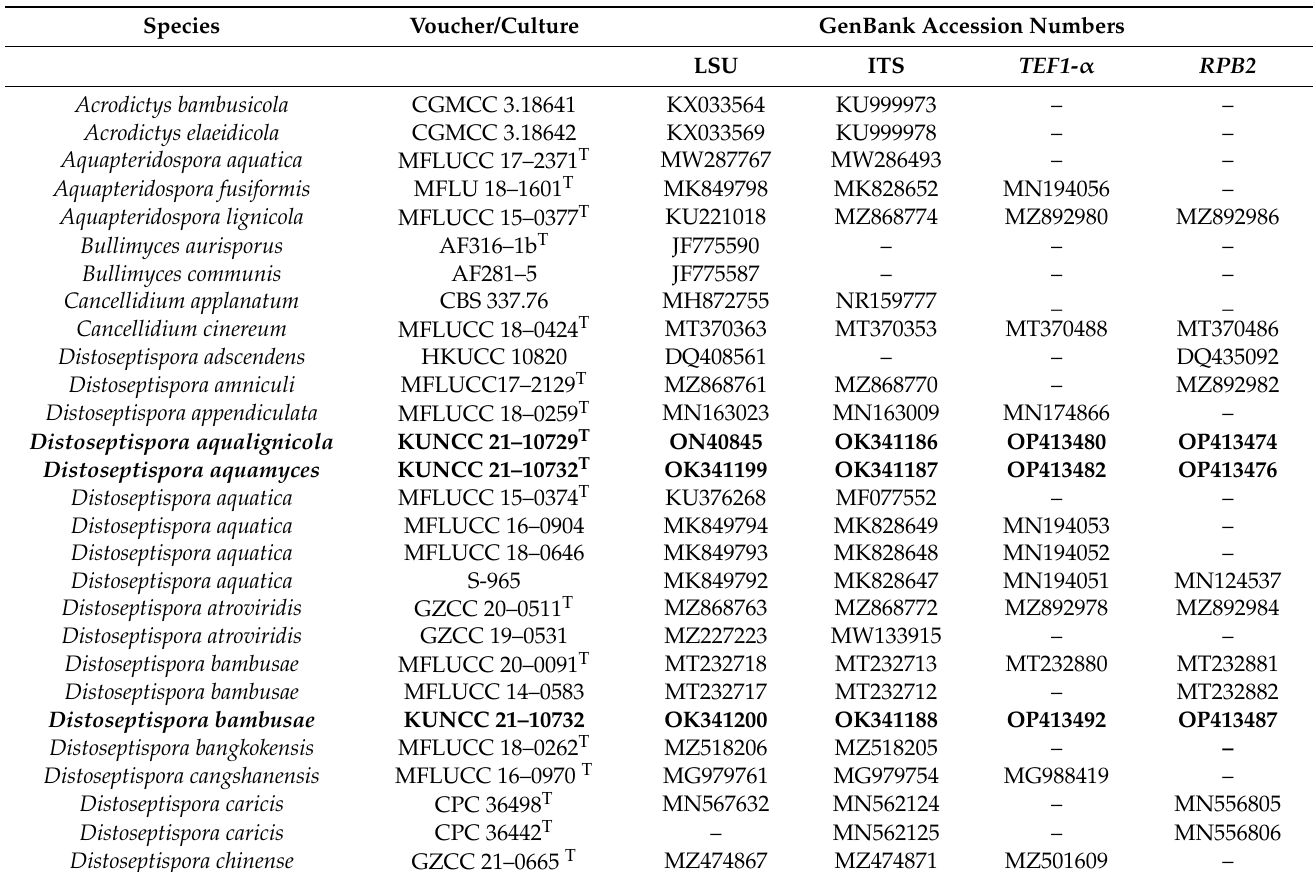
Table 2. Taxa used in the phylogenetic analyses and their corresponding GenBank accession